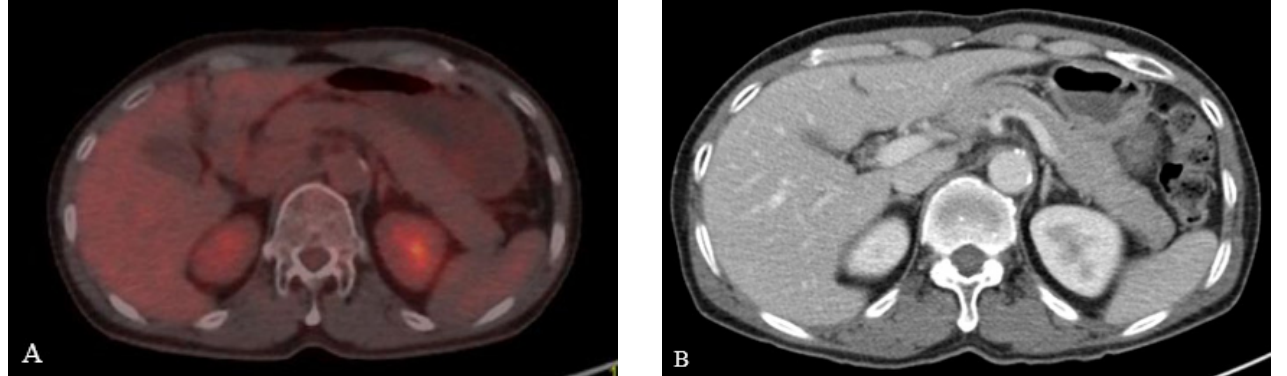
Figure 1. Pancreas findings before chemotherapy. ( A ) There was no finding of presenting malignancy in pancreas on PET CT. ( B ) No abnormal findings suggestive of acute pancreatitis were observed in CT.